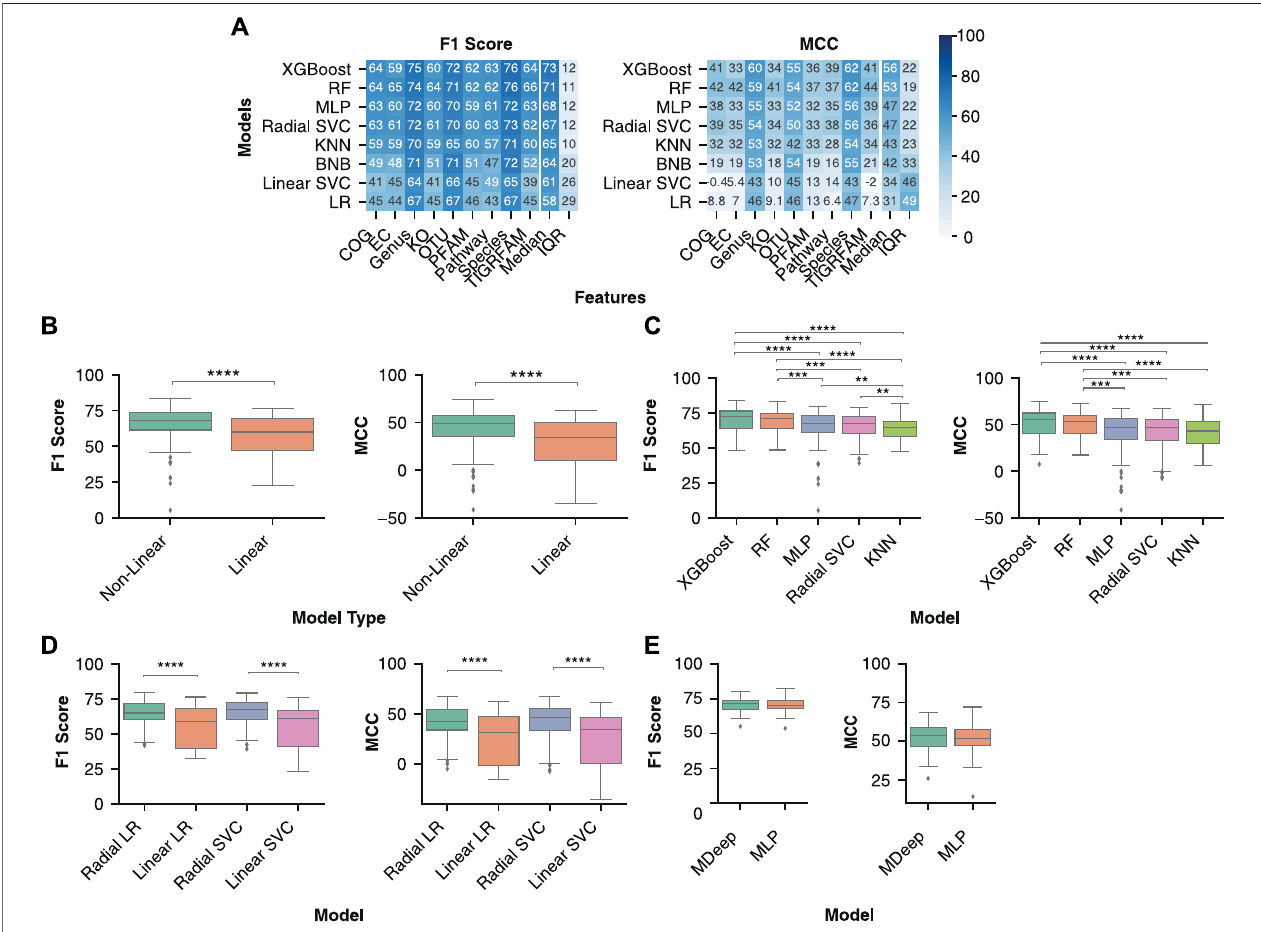
FIGURE 2 | Non-linear models are better suited to identify decision boundaries between control and IBD samples than linear models. (A) Median model performance for each feature set across normalization, transformation, and batch effect correction methods. Rows were sorted in descending order by median performance across all feature sets. (B) Performance distribution of non-linear (RF, MLP, KNN, XGBoost, radial SVC) and linear (BNB, Linear SVC, LR) models. (C) Distribution of classi fi cation performance with the non-linear and linear variations of logistic regression and support vector machines across all feature sets. (D) Distribution of IBD classi fi cation performance between the non-linear models. The analysis comprised datasets preprocessed using all normalizations and transformations (ILR, CLR, VST, ARS, LOG, TSS, NOT) and batch effect correction (no batch effect correction, zero centering, MMUPHin #1, MMUPHin #2) methods performed on all feature types. (E) Comparison of two neural network architectures: the convolutional neural network MDeep or a MLP. A Mann-Whitney U test with Bonferronicorrectionwasperformedtocompareallpairwisecombinationsofmodelswiththesigni fi cantcomparisonsindicated.**indicates p -value < 0.01,***indicates p -value < 0.001, **** indicates p -value <